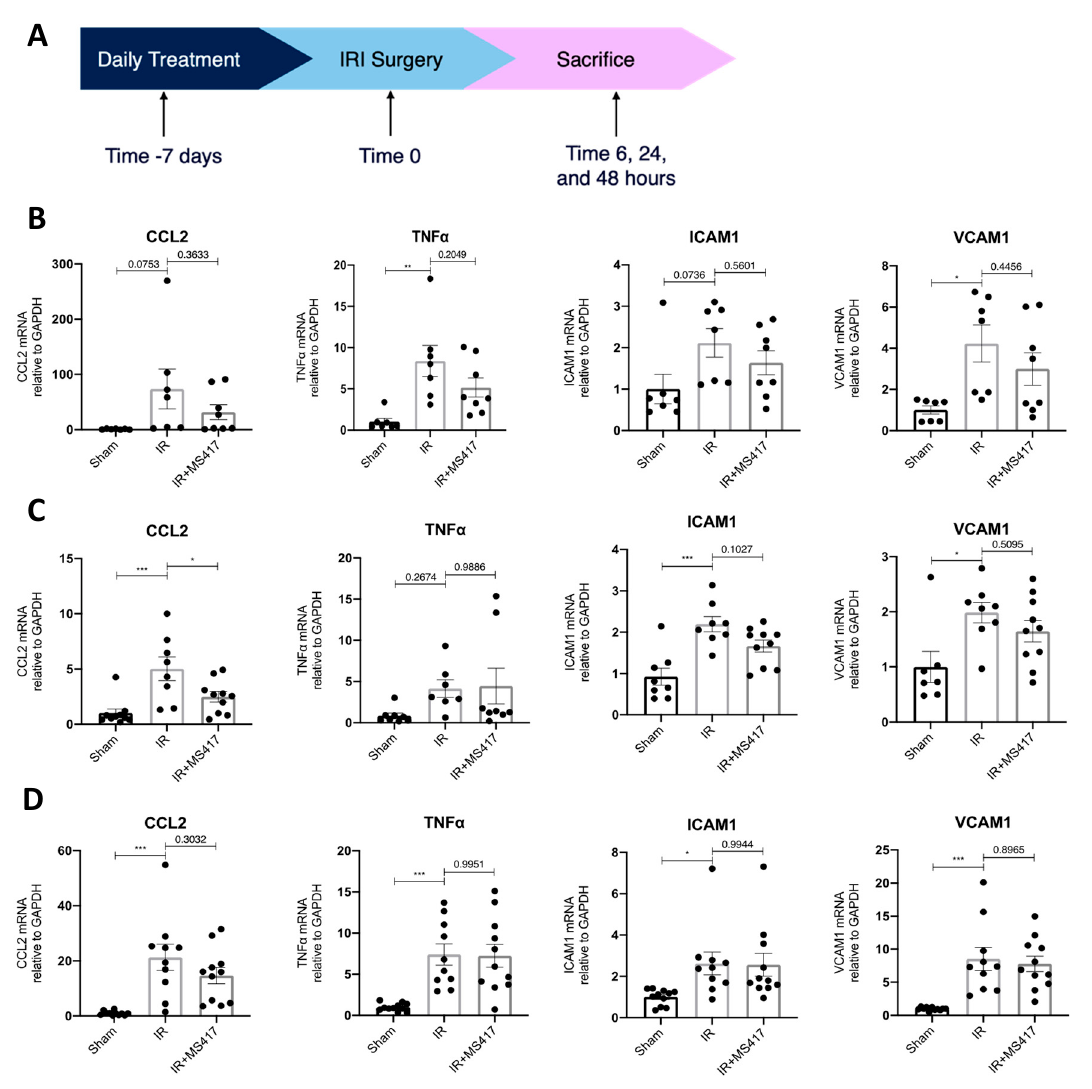
Figure 6. BRD4 inhibition attenuated gene expression in vivo following IRI. ( A ) A schematic representing the in vivo experimental design. C57BL / 6 mice were treated with 1 µ M MS417 daily for 7 days by oral gavage before unilateral IRI. Mice were sacrificed at 6 ( B ), 24 ( C ), and 48 ( D ) hours post-IRI and kidney tissue was collected for qPCR analysis of pro-inflammatory cytokines (CCL2 and TNF α ) and adhesion molecules (ICAM1 and VCAM1). n = 7–11, * p < 0.05, ** p < 0.01, *** p < 0.001.